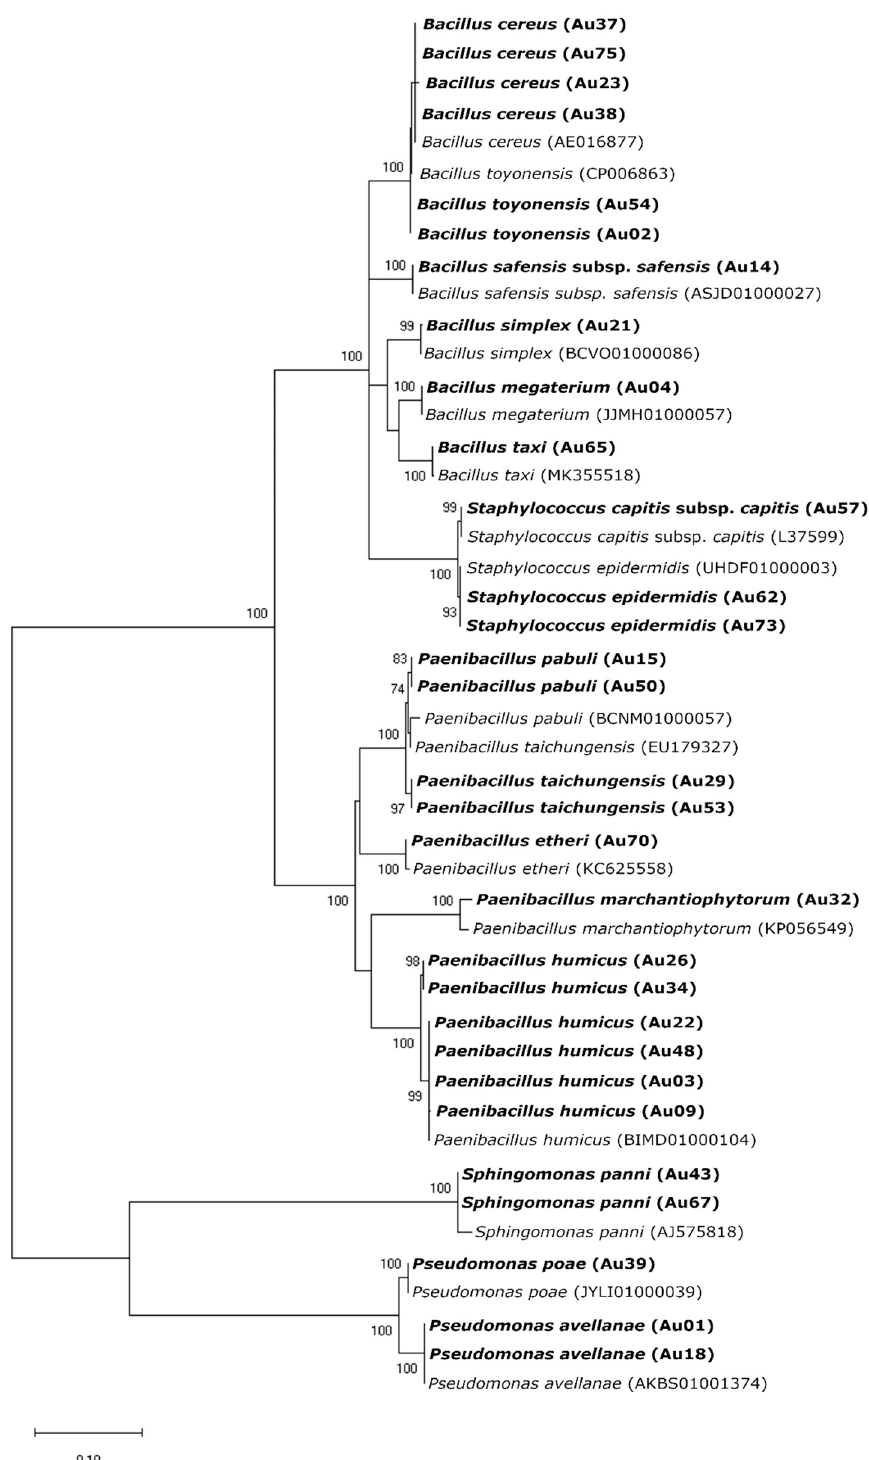
Figure 1. Maximum Likelihood (ML) phylogenetic tree based on 16S rRNA sequences of endophytic bacteria and sequences obtained from the EZBioCloud database. The ML tree was constructed using the Kimura 2 parameter model (K2) and gamma-distributed (+G) with invariant sites (+I) (=K2+G+I). All positions containing gaps and missing data were included for analysis. Clade supports were calculated based on 1000 replicate runs. Accession numbers (GeneBank) of the sequences belonging to the endophytic bacteria isolated in this study and the reference sequences from EZBioCloud are listed in Table